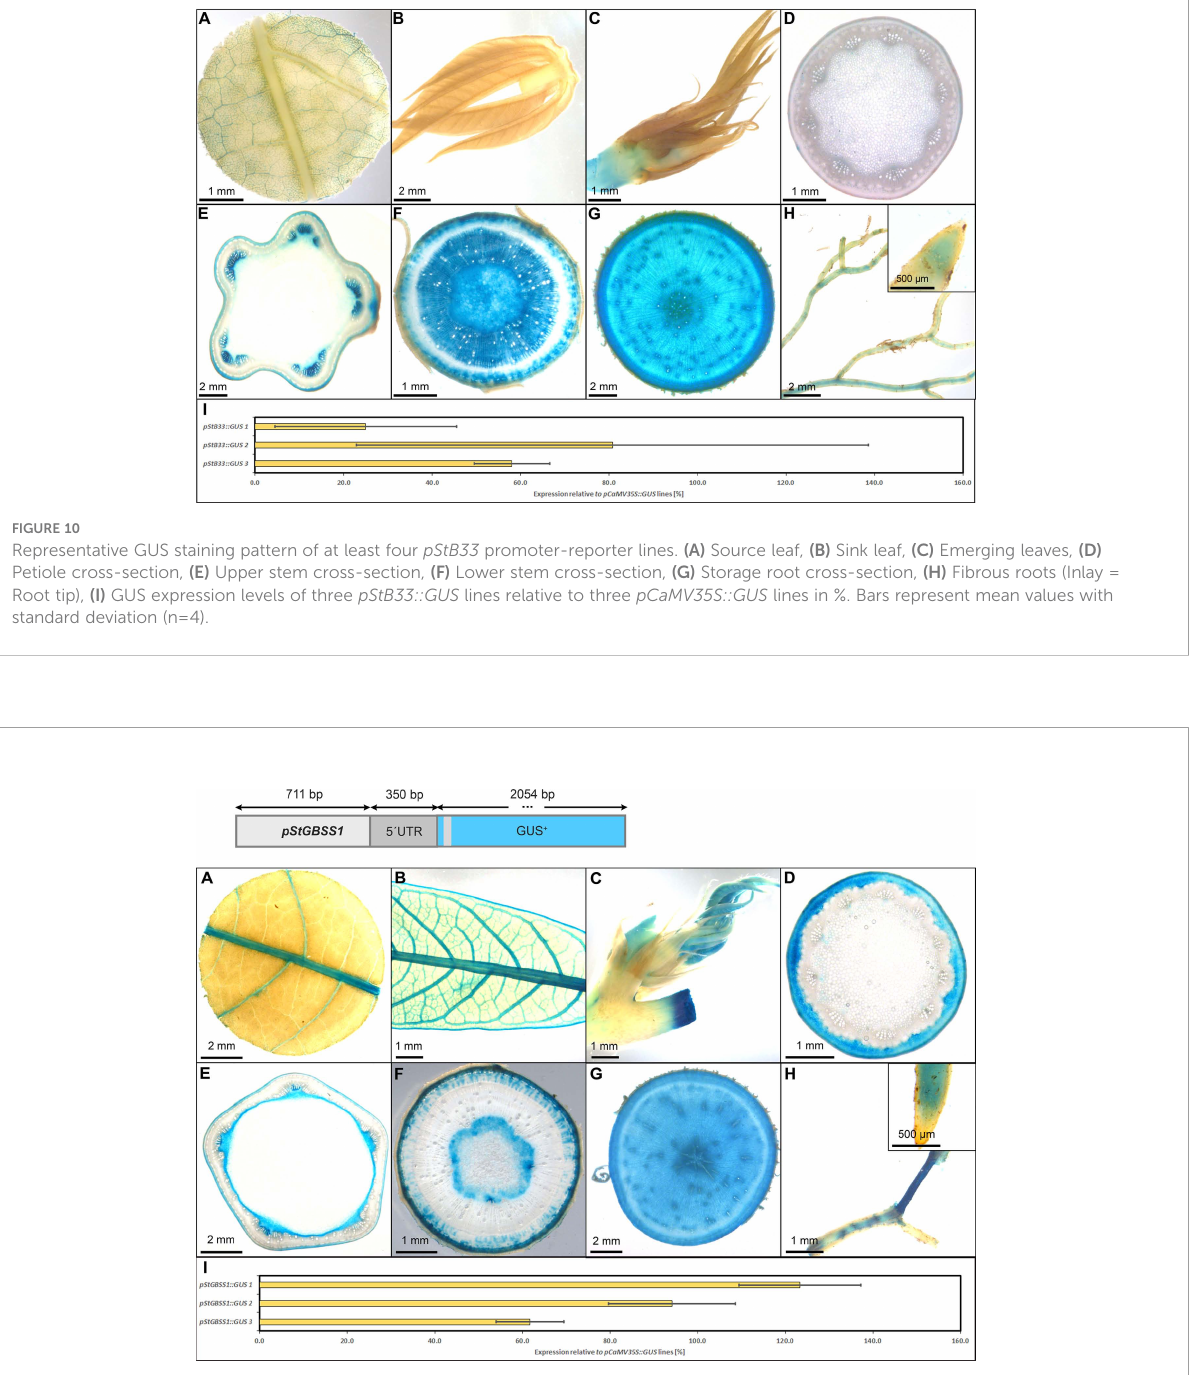
FIGURE 11 Representative GUS staining pattern of four pStGBSS1 promoter-reporter lines. (A) Source leaf, (B) Sink leaf, (C) Emerging leaves, (D) Petiole cross-section, (E) Upper stem cross-section, (F) Lower stem cross-section, (G) Storage root cross-section, (H) Fibrous roots (Inlay = Root tip), (I) GUS expression levels of three pStGBSS1:GUS lines relative to three pCaMV35S::GUS lines in %. Bars represent mean values with standard deviation (n=4).